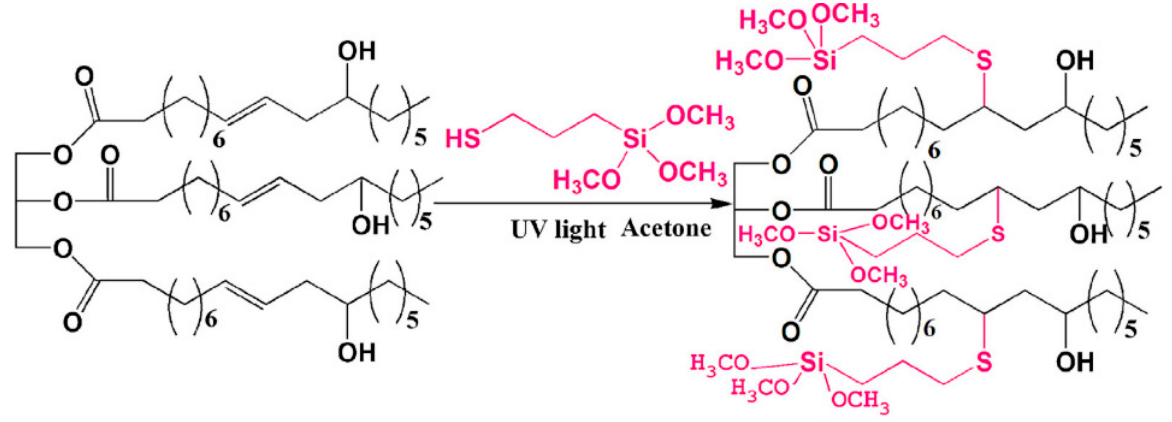
Figure 9. The modification of castor oil with mercaptopropyltrimethoxysilane. Reprinted/adapted with permission from Ref. [30]. Copyright (1997), with permission from Elsevier.